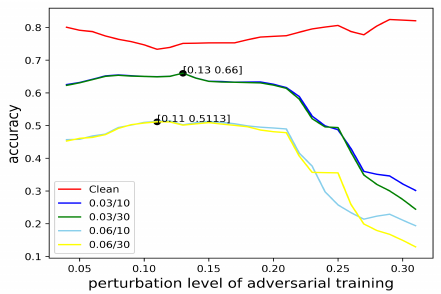
Figure 7. The robust evaluation of adversarial